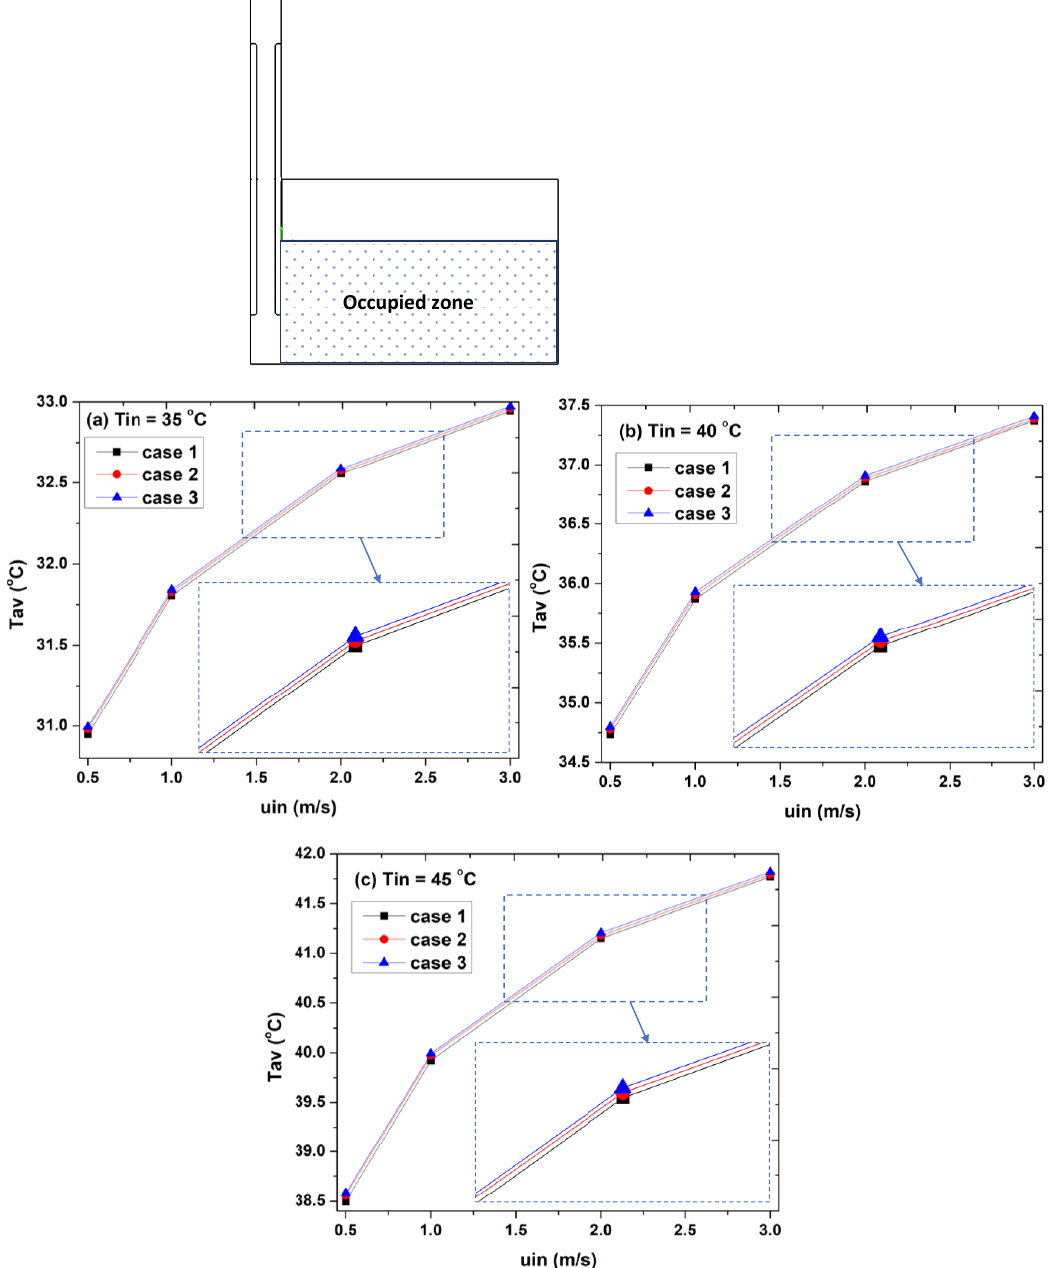
Figure 8. Effect of the inlet velocity on the average temperature in the occupied zone.